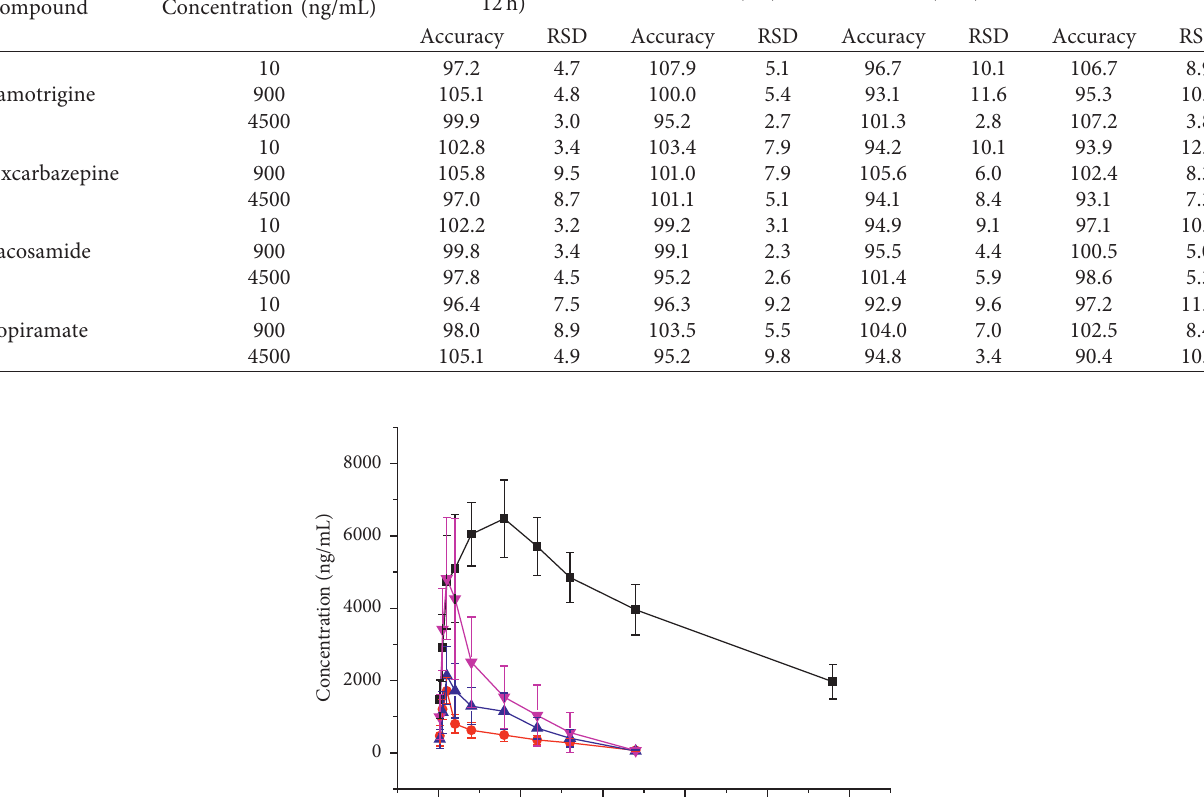
Table 3: Stability of lamotrigine, oxcarbazepine, lacosamide, and topiramate in rat plasma under various storage conditions ( n � 3).